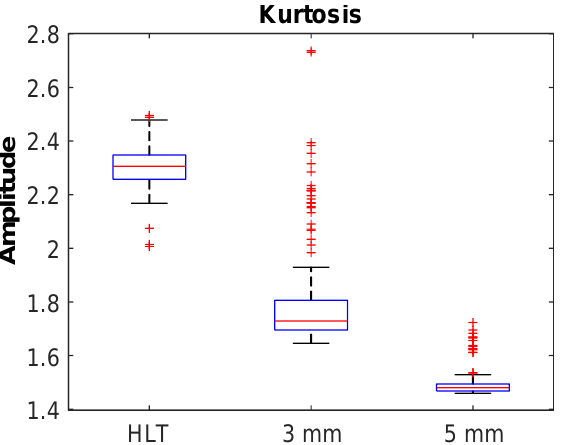
Figure 7. Boxplots that determine the range of kurtosis for every condition of the bearing. Through the boxplots in Figure 7, it can be noted that on the “ x ”-axis the labels “HLT”, “3 mm”, and “5 mm” represent the bearing conditions healthy, severity 1, and severity 2, respectively. On the “ y ”-axis are the amplitude values that every boxplot spans. Congruently, the ranges that determine the severity of the faults are summarized in Table 4. Table 4. Ranges for condition detection according to the kurtosis statistical indicator. Bearing Condition